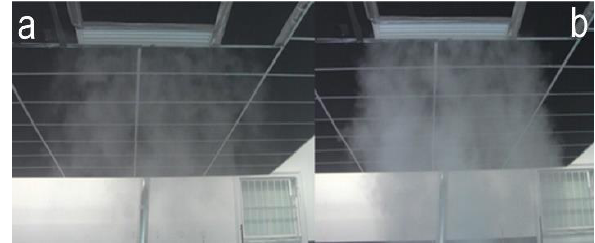
Fig. 6 . Smoke test of the SLN diffuser, with outflow directed downwards, for two air streams: (a) - 120 m 3 /h, (b) - 480 m 3 /h.